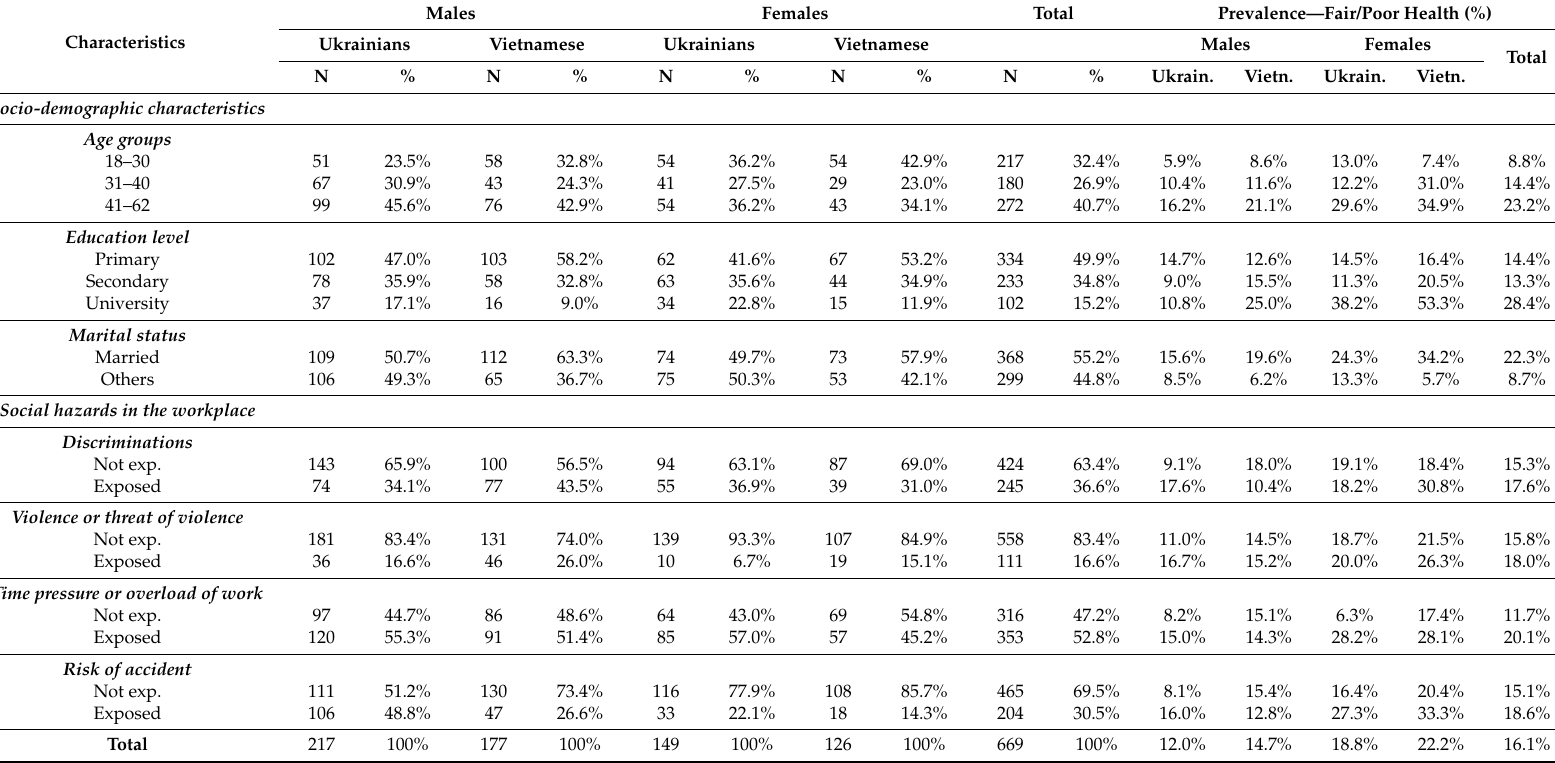
Table 1. Sample characteristics, workplace exposition and prevalence of not good self-rated health (N =